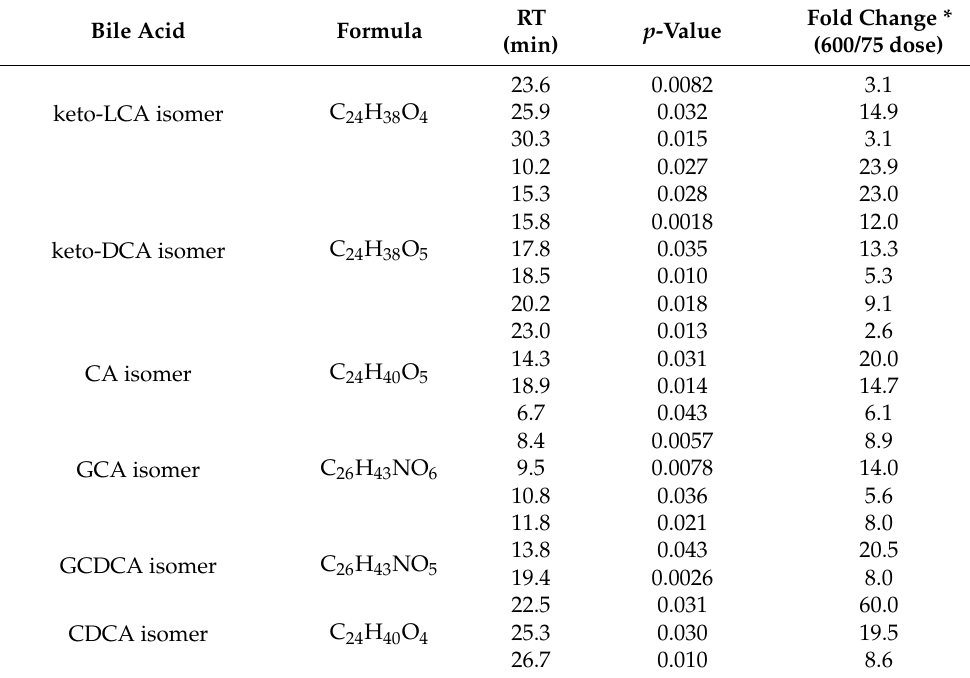
Figure 3. Extracted ion LC-MS chromatograms, in negative ion mode, of tentatively assigned bile acid isomers having significant changes between low and high APAP dosing. Peaks from a rat treated with 75 and 600 mg/kg APAP are shown in red or blue, respectively. Peaks annotated with * were decreased by 4×. Table 1. Tentatively assigned bile acid isomers with significant changes between low and high APAP